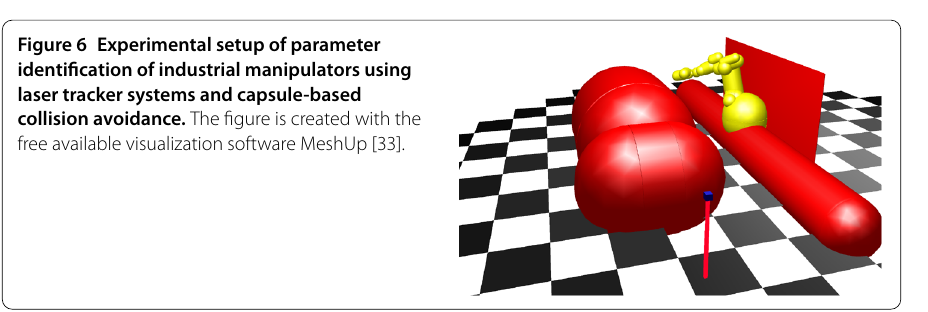
Figure 6 Experimental setup of parameter identification of industrial manipulators using laser tracker systems and capsule-based collision avoidance. The figure is created with the free available visualization software MeshUp